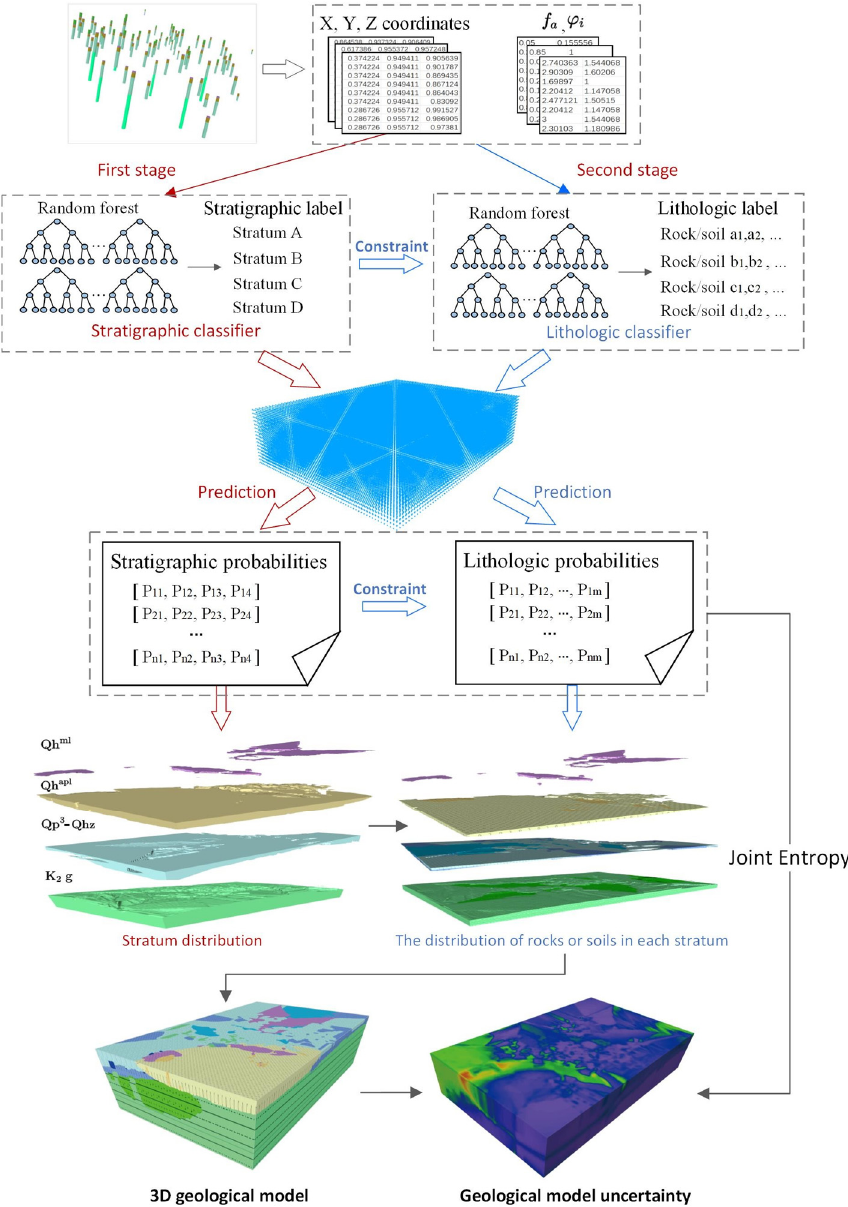
Figure 2. Flowchart of the proposed geological modeling framework in this paper. The modeling work contains stratigraphic classification, lithologic classification, and classification uncertainty evaluation. The path indicated by the red arrows on the left is the stratigraphic classification process by using an RF, and the blue on the right is the lithologic classification process with the constraint of stratigraphic classification results.